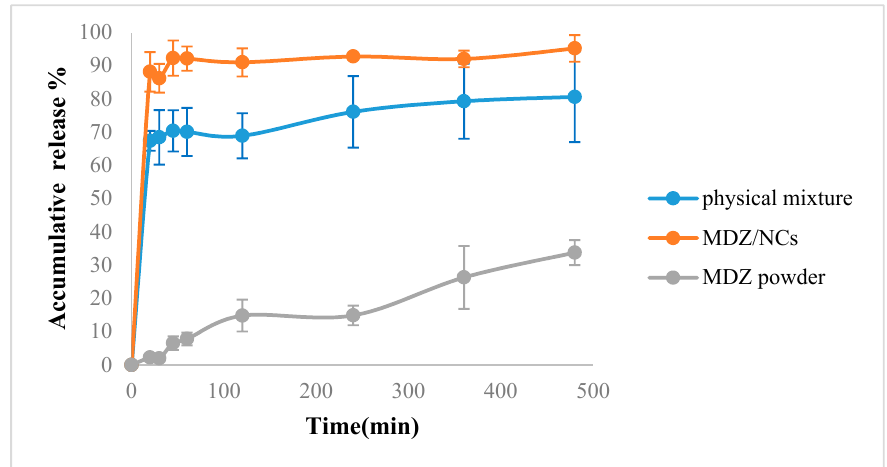
Figure 6. In vitro release profiles of the MDZ/NCs, the physical mixture, and the MDZ coarse powder in phosphate-buffered saline at pH 7.4. Abbreviations: MDZ/NCs, MDZ nanocrystals; MDZ/S, MDZ solution; DZP/S, diazepam solution.